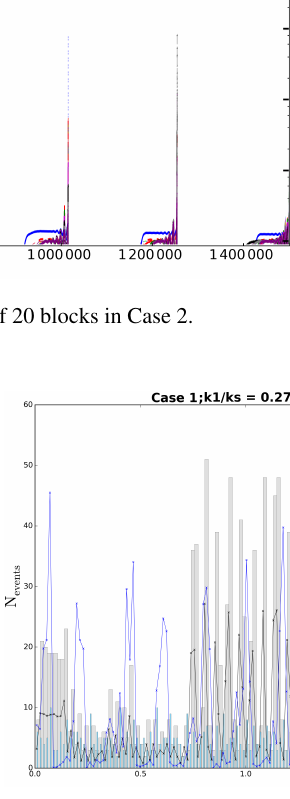
Figure 31. Time variation of seismic